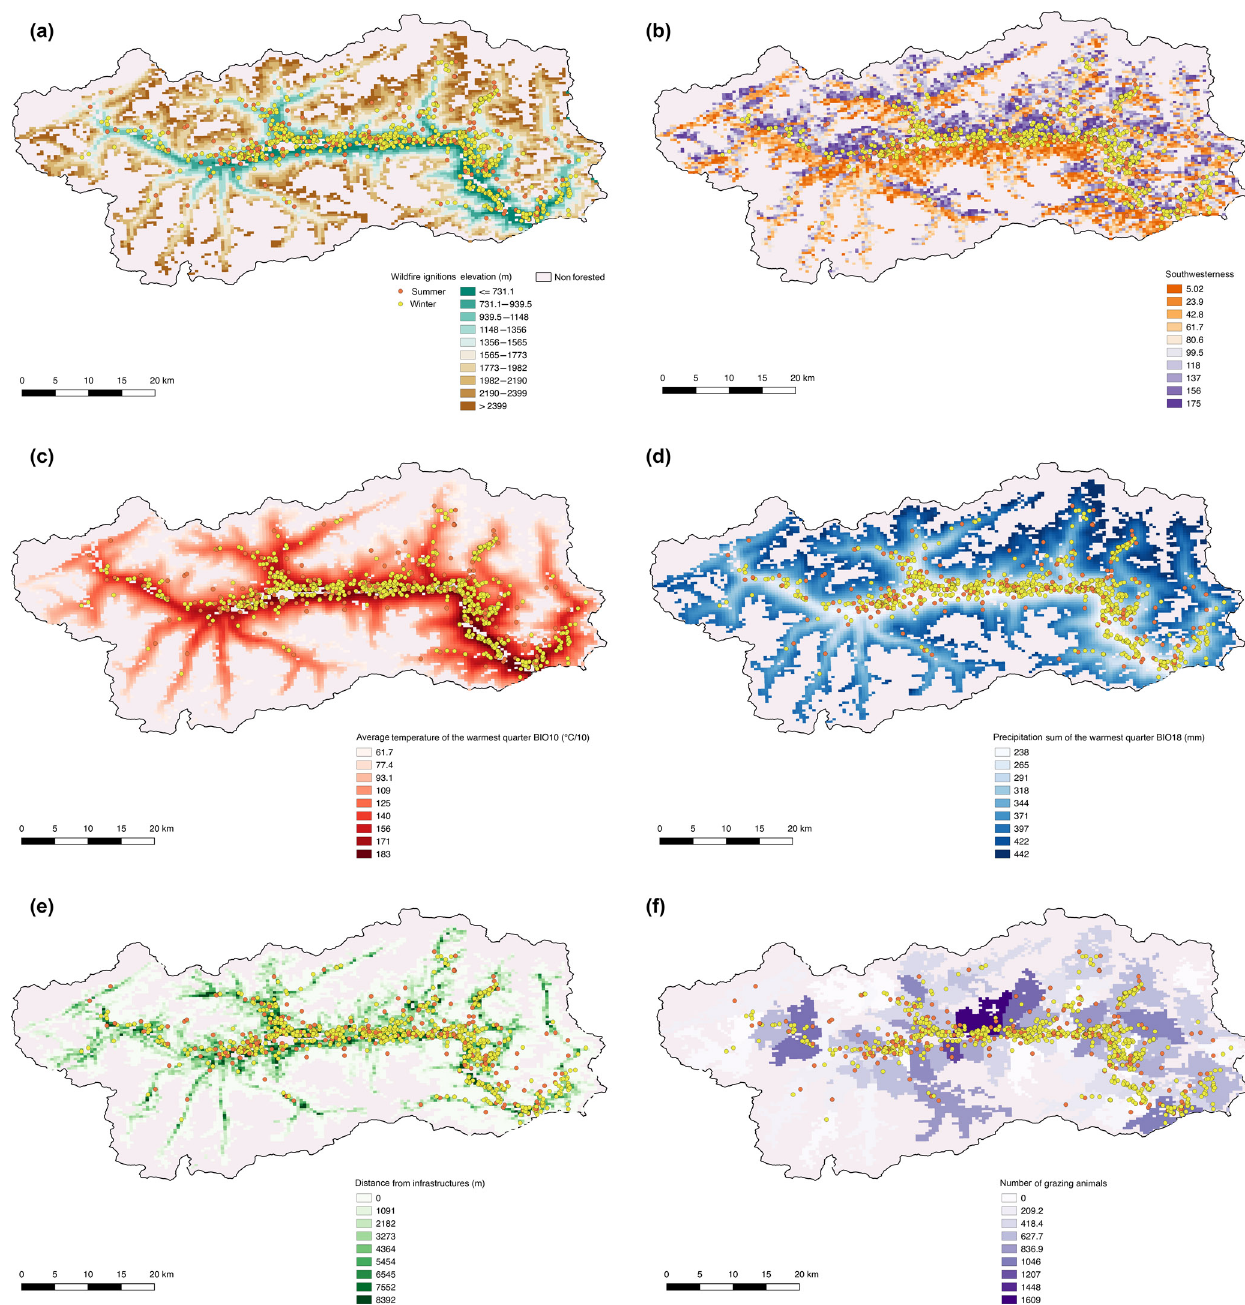
Figure 3. Spatial distribution of summer and winter fire ignition over (a) elevation, (b) aspect (linearized), (c) mean temperature of the warmest quarter, (d) total precipitation of the wettest quarter, (e) distance from infrastructures, and (f) number of grazing animals per municipality, plotted over the distribution of forest